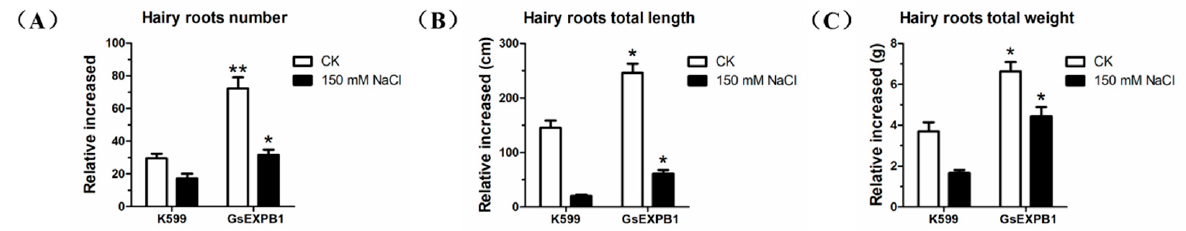
Figure 11. Phenotypic quantification results of soybean hairy roots overexpressed GsEXPB1. ( A ) Rel- ative increase in the number of hairy roots. ( B ) Relative growth of total root length. ( C ) Relative increase in total root weight. * indicates a significant difference from K599 (*, p < 0.05; **, p < 0.01) (n = 50).